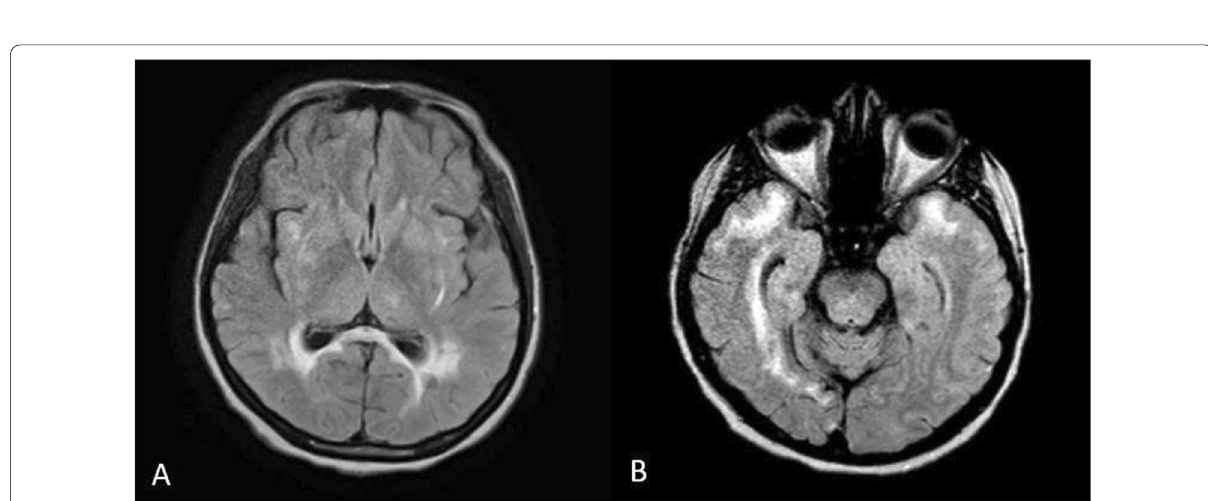
Fig. 5 A and B Showing T2 FLAIR images with hyperintense signal changes in bilateral anterior temporal lobes and external